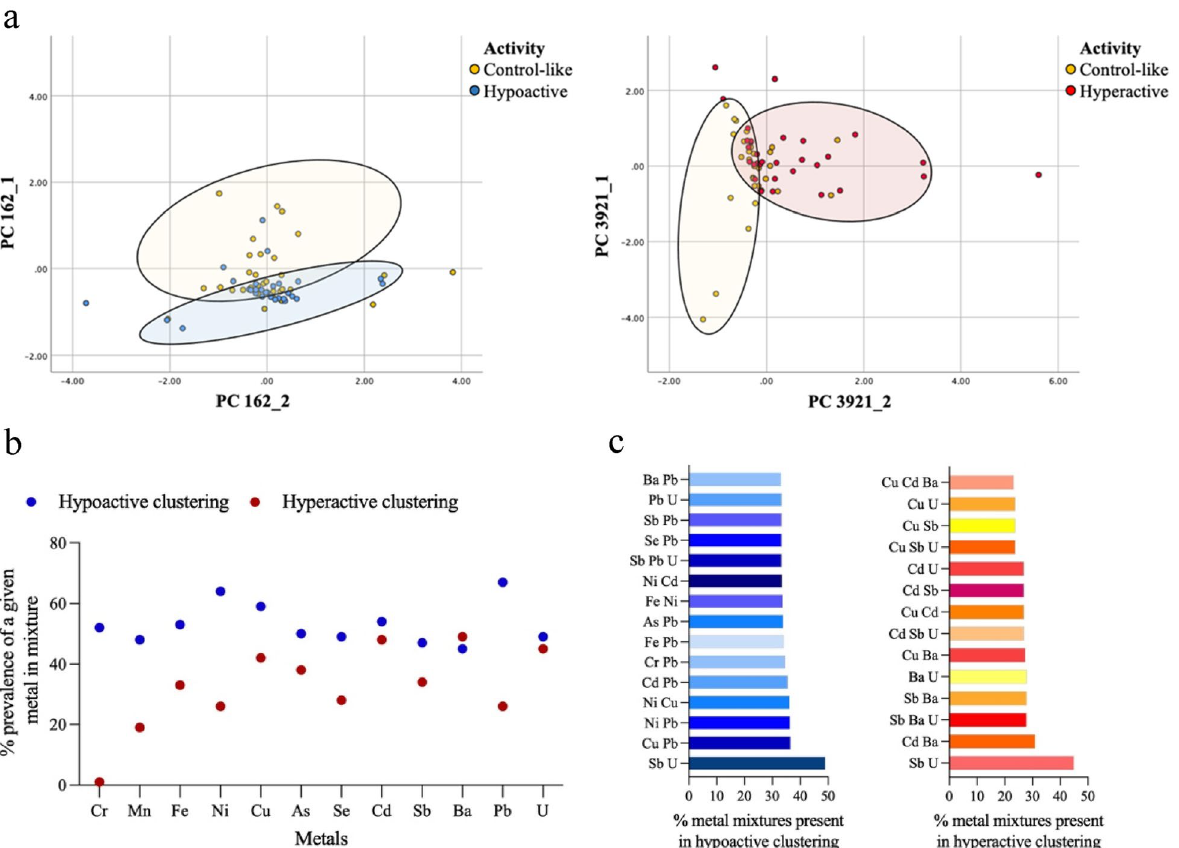
Figure 4. ( a ) Examples of principal component analysis (PCA) derived scatter plots that show significant clustering between control-like and hypoactive and control-like and hyperactive behaviors from metal combination inputs of Cr, Mn, Fe, Se, Cd, Sb, Ba, Pb, & U (combination 162) and Fe, Ni, Cu, Se, Pb, & U (combination 3921) respectively. ( b ) Dot plot representing the percent prevalence of a given metal in mixtures that resulted in significant clustering between control-like and hyperactive (red) as well as control-like and hypoactive (blue) behavior. ( c ) Bar graphs representing the top 15 combinations of two or three metals within mixture subsets that resulted in significant clustering between control-like and hypoactive and control-like and hyperactive behavior. Clusters were created via PCA and an F-statistic was calculated to determine significance, p value <